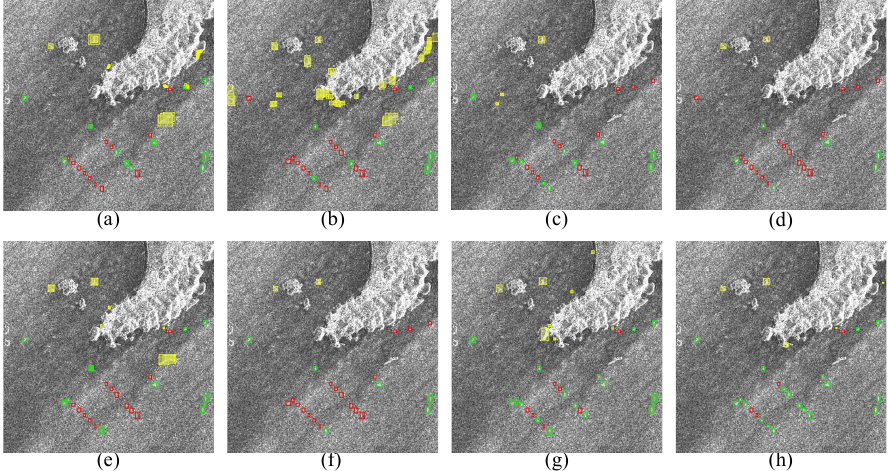
Figure 14. Visualization of detection results with different detectors in scene 5. ( a ) RetinaNet. ( b ) ATSS. ( c ) YOLOv5. ( d ) Faster R-CNN. ( e ) Double-head R-CNN. ( f ) Cascade R-CNN. ( g ) Dynamic R-CNN. ( h ) The proposed method.